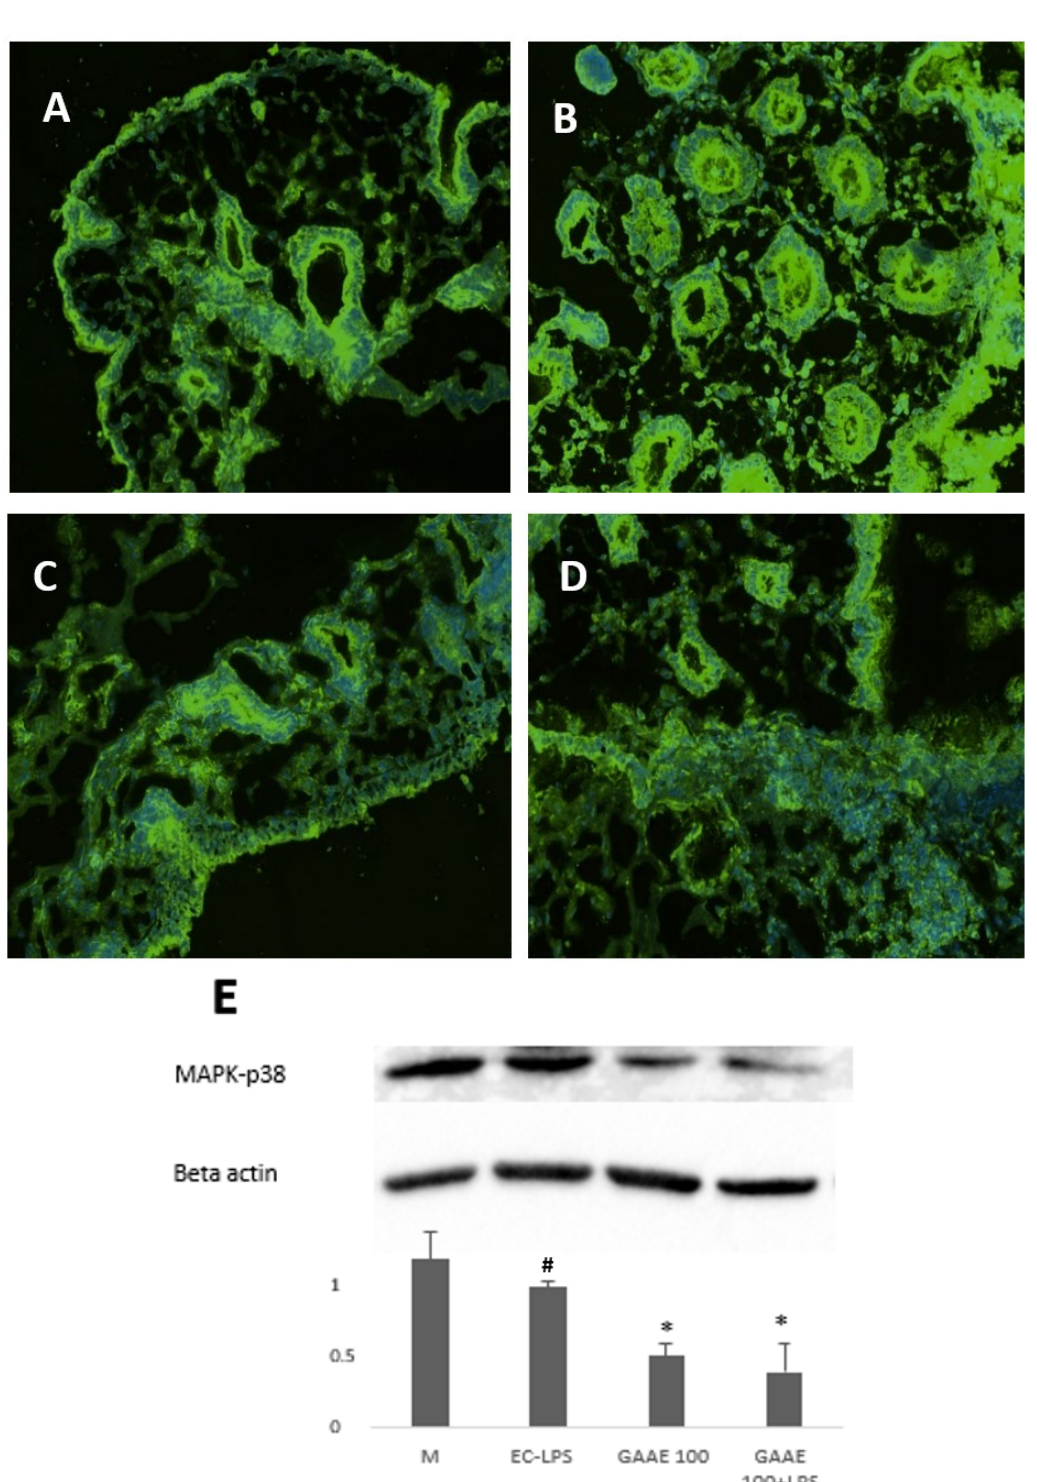
Figure 11. GAAE pre- treatment effect on p38 MAPK expression in UC patient biopsies challenged with EC-LPS. ( A ) No treated biopsy; ( B ) biopsy challenged with 1 µg/mL EC - LPS; ( C ) biopsy treated with 100 µg/mL GAAE; ( D ) biopsy cotreated with 100 µg/mL GAAE and 1 µg/mL EC - LPS; ( E ) Western blotting with the same treatments. Results are expressed as means ± S.E.M. ( N = 31), * p < 0 . 05 vs. EC - LPS, # p < 0 . 05 vs. medium (Student’s t - test).